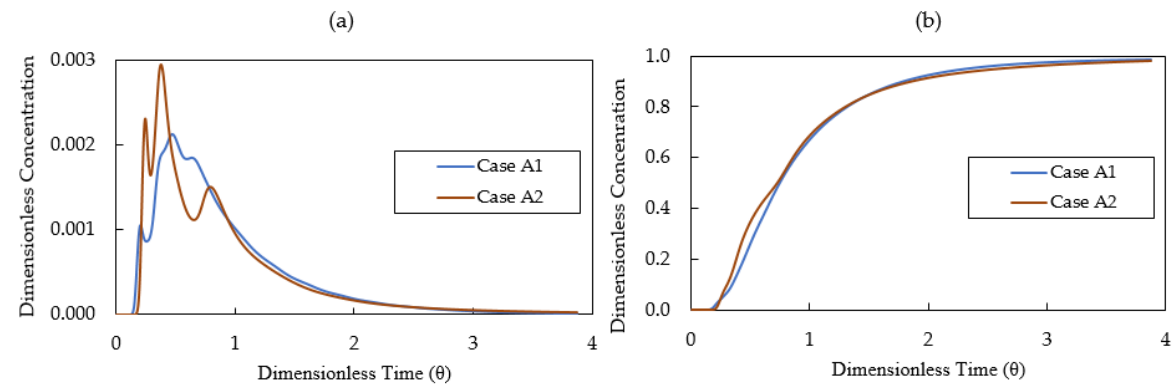
Figure 12. ( a ) E-curve and ( b ) F-curve for Case A1—without thermal buoyancy and Case A2—with thermal buoyancy. Table 4. RTD analysis for Case A1 and Case A2.